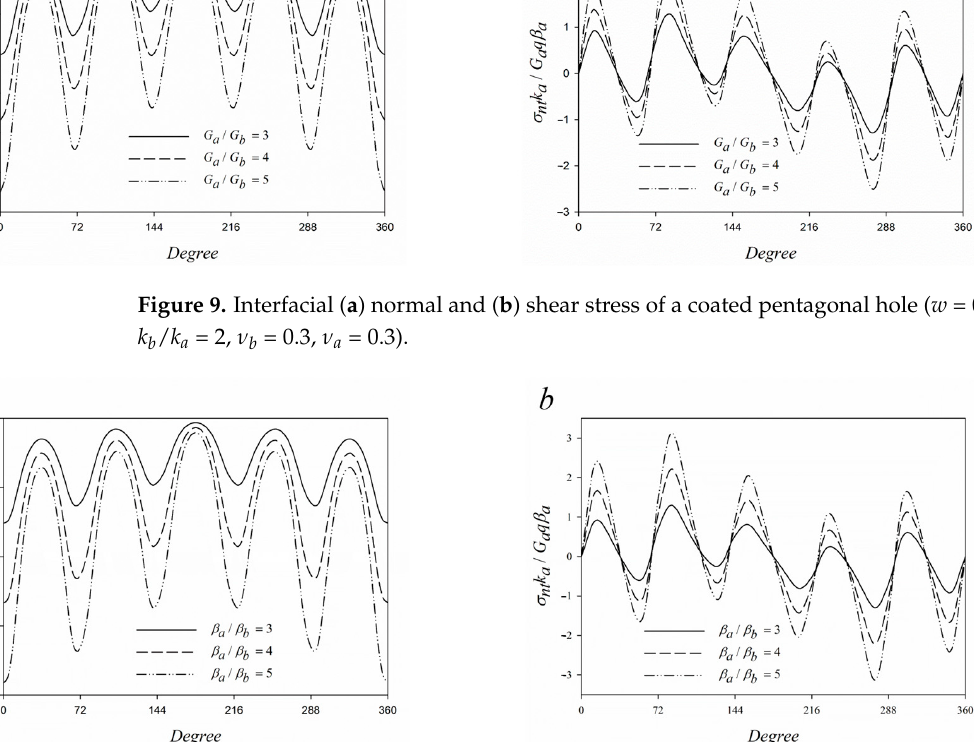
Figure 11. Interfacial ( a ) normal and ( b ) shear stress of a coated pentagonal hole ( G b / G a = 3 , β b / β b = 3 , k b / k a = 2 , ν b = 0.3 , ν a = 0.3). Table 2. The interfacial normal stress of each corner of the pentagonal hole with different parame- ters.